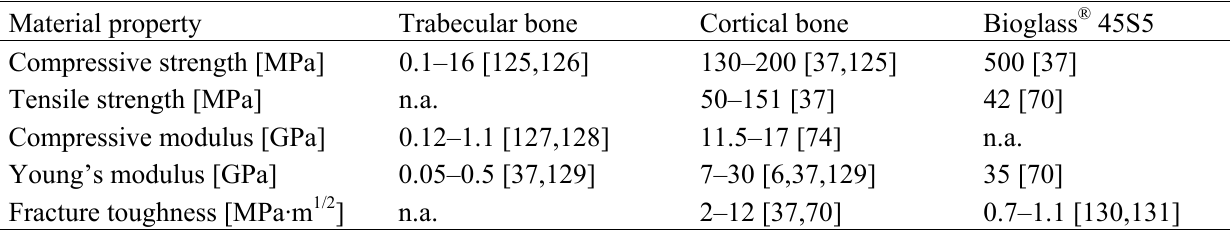
Table 2. Mechanical properties of human cancellous and cortical bone in comparison to dense bioactive glass 45S5 Bioglass ®